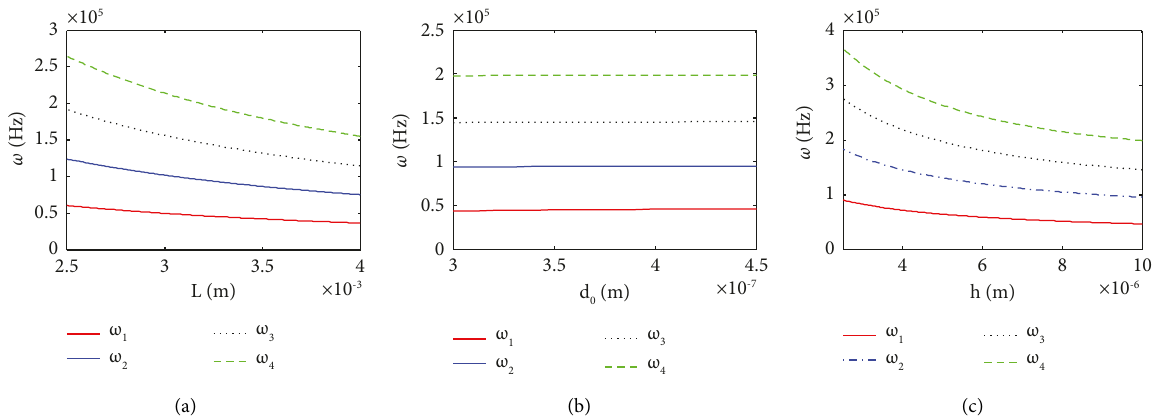
Figure 7: Changes of the resonant frequencies with system parameters (odd modes) (a) length changes (b) clearance changes (c) thickness changes.